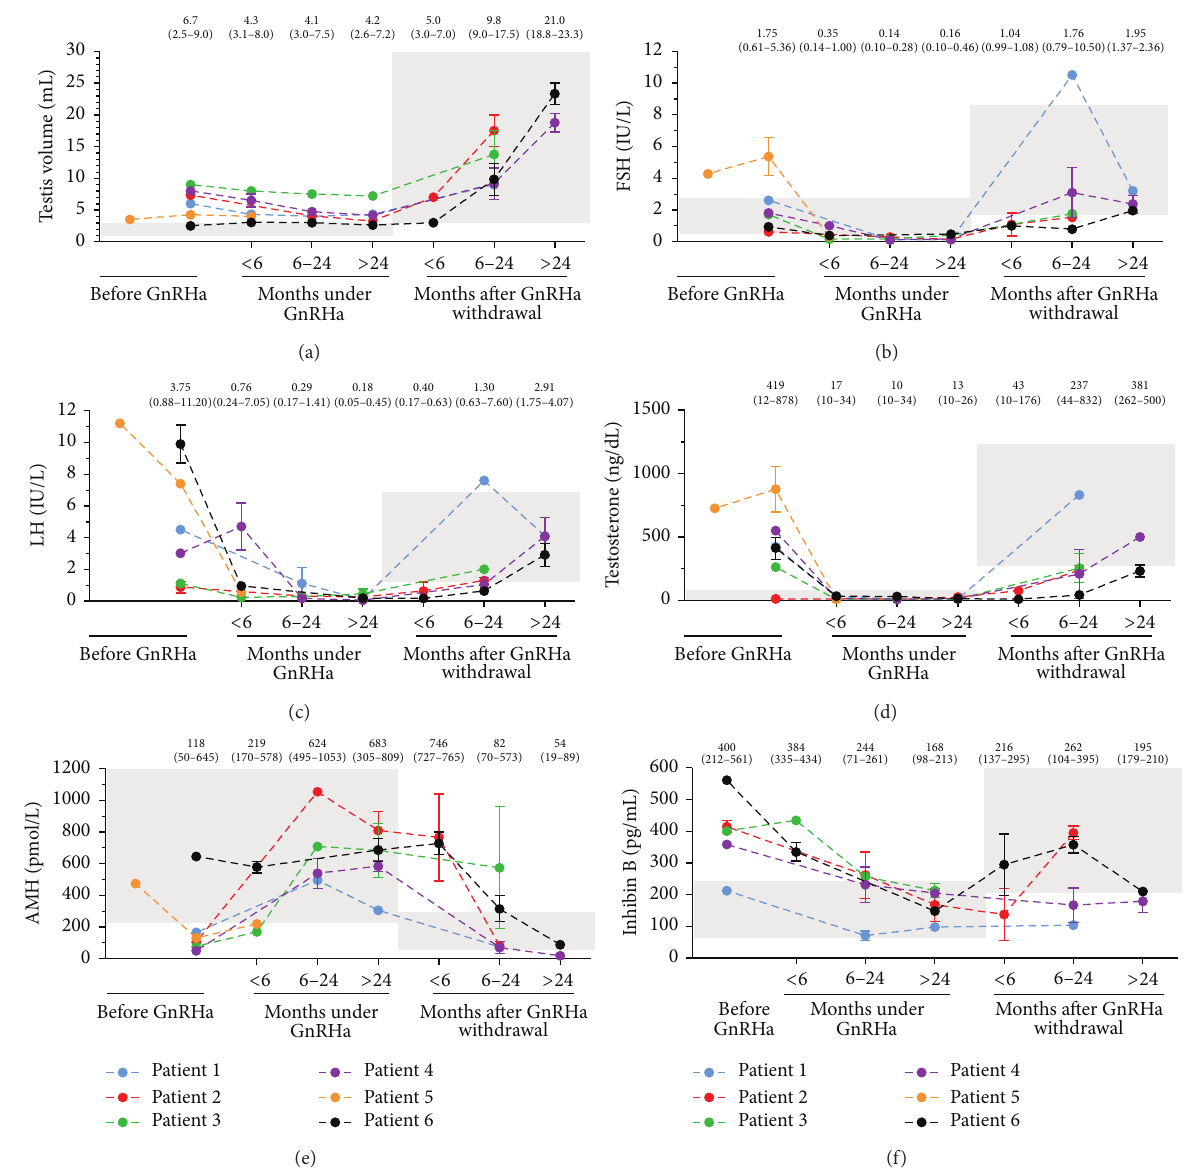
Figure 1: Testicular volume and hormone levels of boys with central precocious puberty before, during, and after withdrawal of GnRH analogue treatment. Medians and ranges are shown on the top of each figure for each time